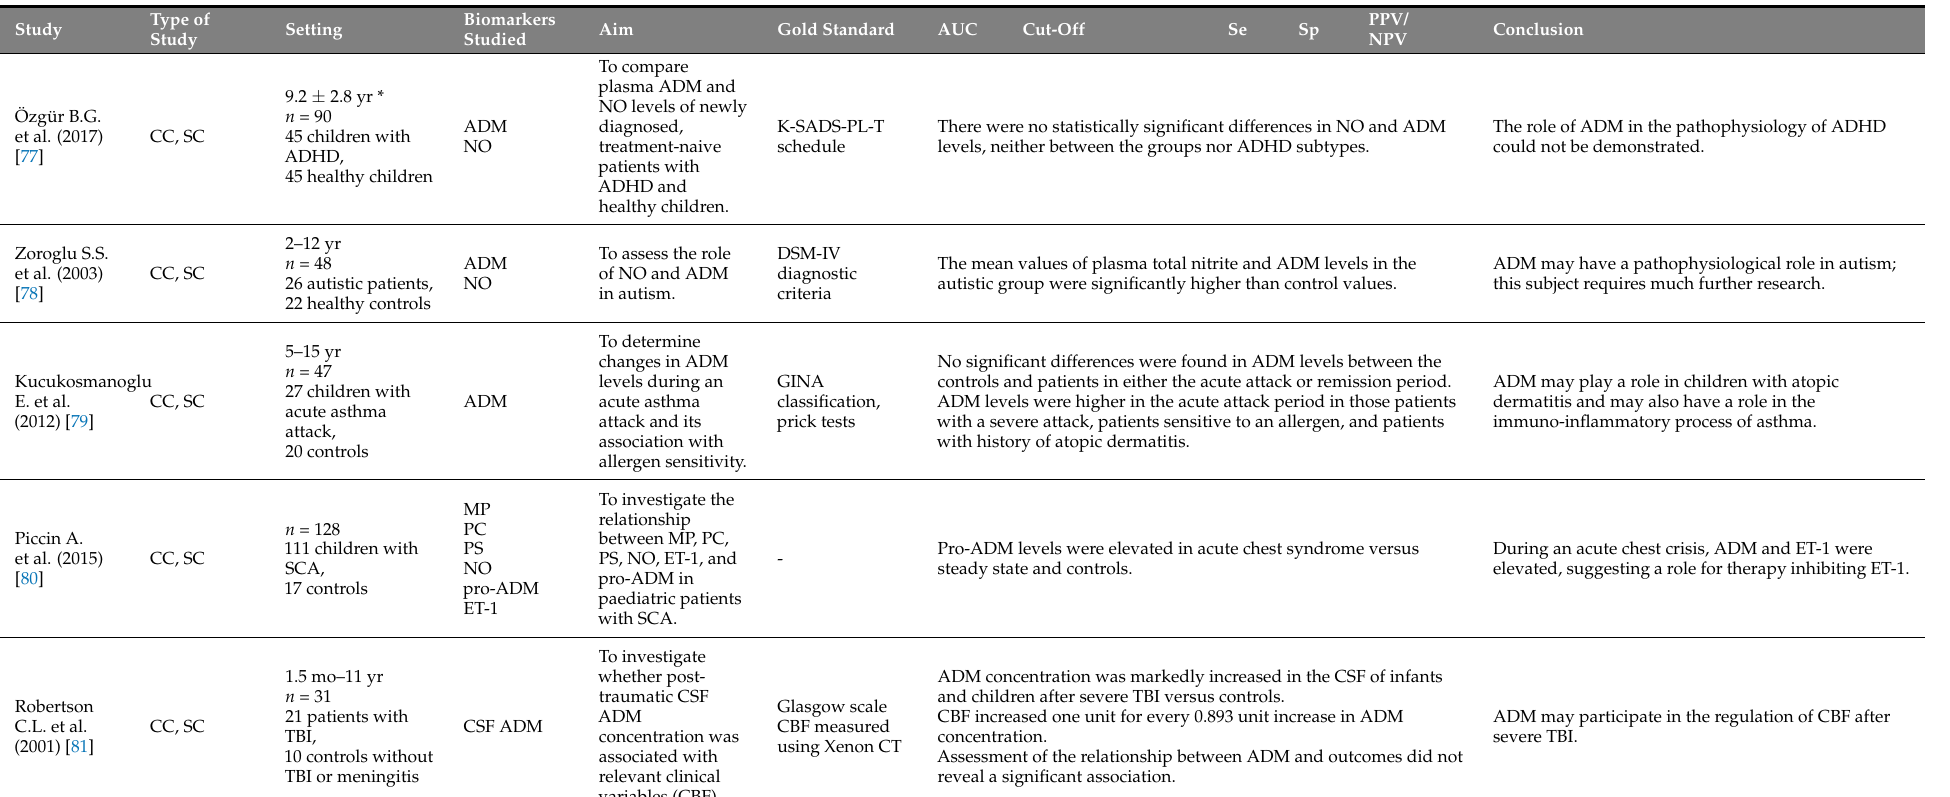
Table 7. Other articles published on adrenomedullin in